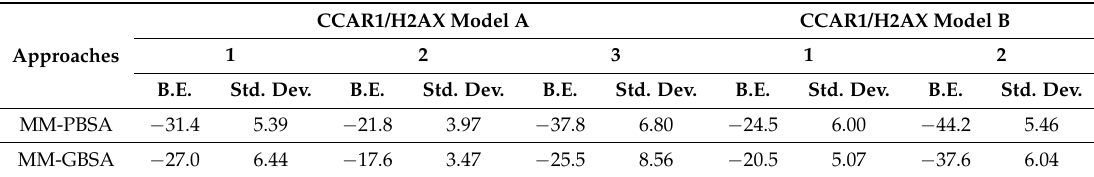
Table 1. Calculation of the binding energies (BE) (Kcal/M) of the CCAR1/H2AX model interactions using MM-PBSA and MM-GBSA.